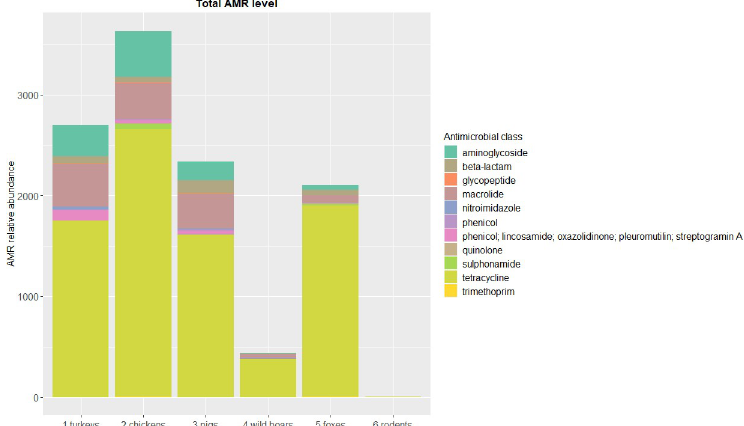
Fig 1. Total level of antimicrobial resistance genes by drug class and animal source. Stacked column chart with relative abundances (FPKM) of AMR genes aggregated to corresponding drug classes (y-axis) by sample (x-axis). The height of each bar chart relates to the relative AMR gene abundances in a